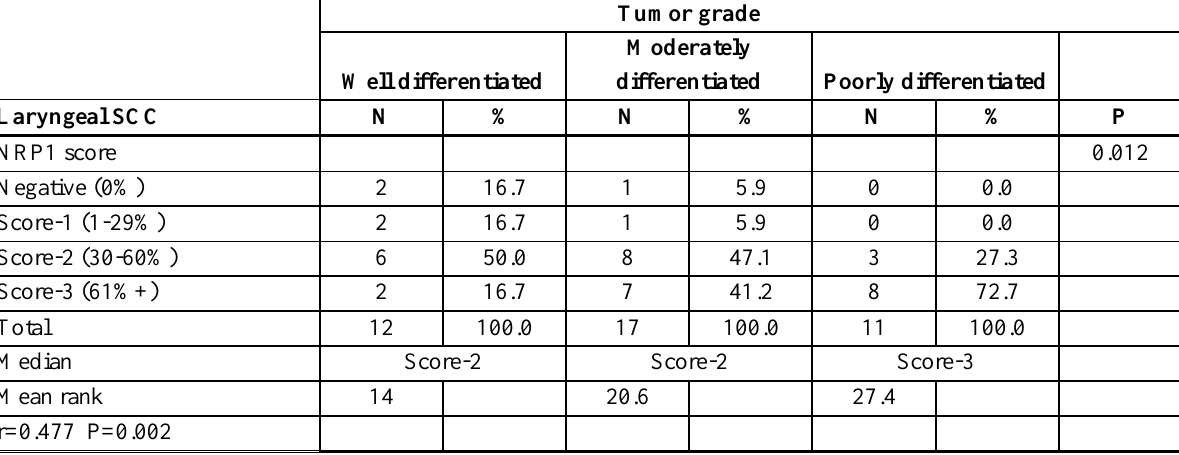
Table 5: The difference in median score category of selected NRP1 marker between the 3 tumor grades among cases with Laryngeal